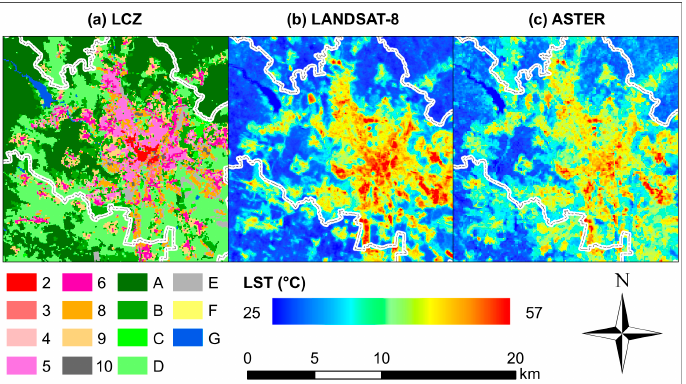
Figure 4. ( a ) Spatial distribution of LCZs and examples of ( b ) LANDSAT-8, scene LT8_20150606, and ( c ) ASTER, scene AST_20110628; surface temperature variability in the Prague area; see Table 3 for the scene ID. LCZ key: 2, compact mid-rise; 3, compact low-rise; 4, open high-rise; 5, open mid-rise; 6, open low-rise; 8, large low-rise; 9, sparsely built-up; 10, heavy industry; A, dense trees; B, scattered trees; C, bush, scrub; D, low plants; E, bare rock or paved; F, bare soil or sand; G, water.